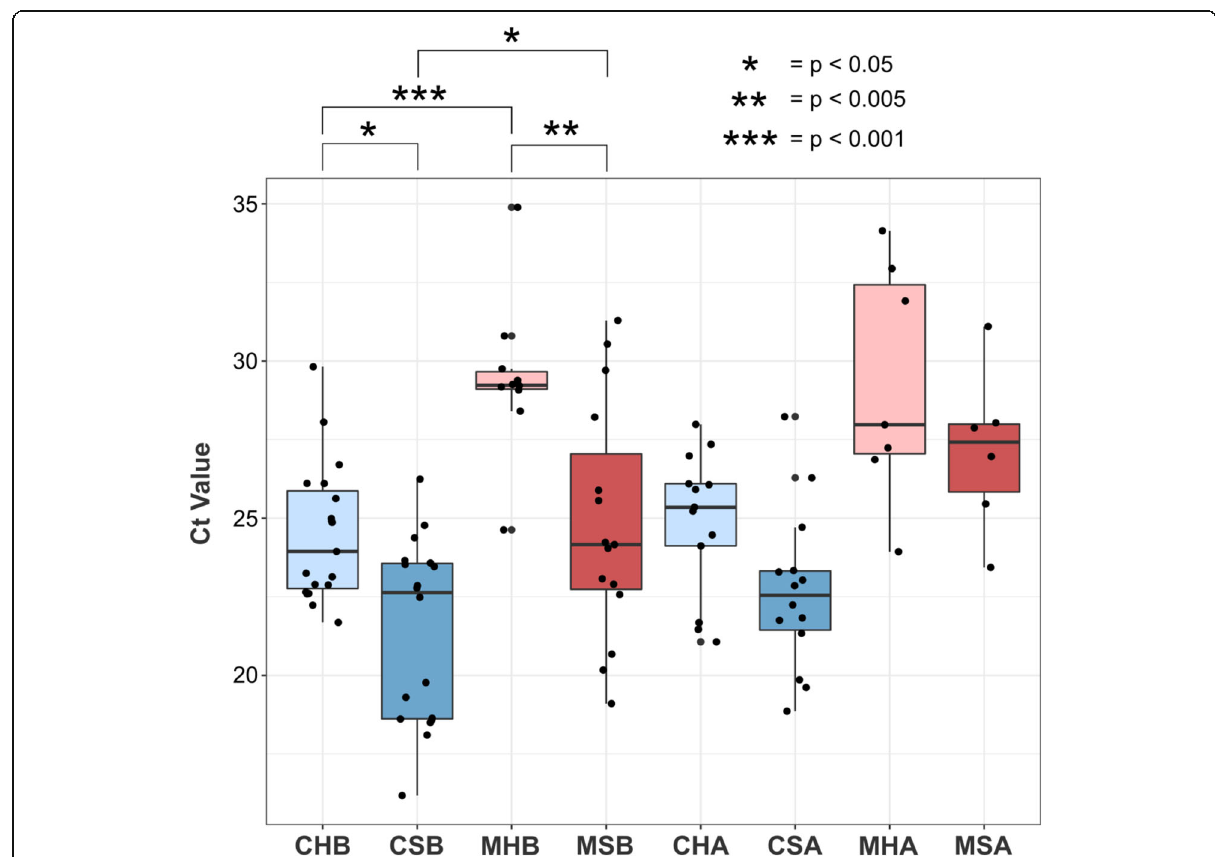
Fig. 4 Ct values comparison across groups of samples. The boxplot shows the qPCR Ct values for all sample groups. Groups of samples before formalin treatment are on the left side of the plot, while those after treatment are on the right. Gut content samples are colored in blue while gut mucosa samples in red. Color intensity discriminates between healthy (light) and sick (darker). ANOVA coupled with a Tukey ’ s HSD post-hoc test for pairwise comparisons was performed. Differences in the mean Ct values across groups can be seen when comparing groups of healthy fish with their sick counterpart (e.g. CHB vs CSB) and when distal gut content groups with their distal gut mucosa counterpart (e.g. CHB vs MHB). Sick fish present lower Ct values than the healthy ones indicating an increase in the total microbial biomass in relation to disease progression, and gut mucosa samples harbor a lower total microbial biomass than the gut content. No difference in the Ct values could be detected in response to formalin treatment indicating a negligible direct effect on the gut total microbial content. Statistically significant differences in the mean Ct value between groups are highlighted for biologically relevant comparisons (see Additional file 9 for all the comparisons p